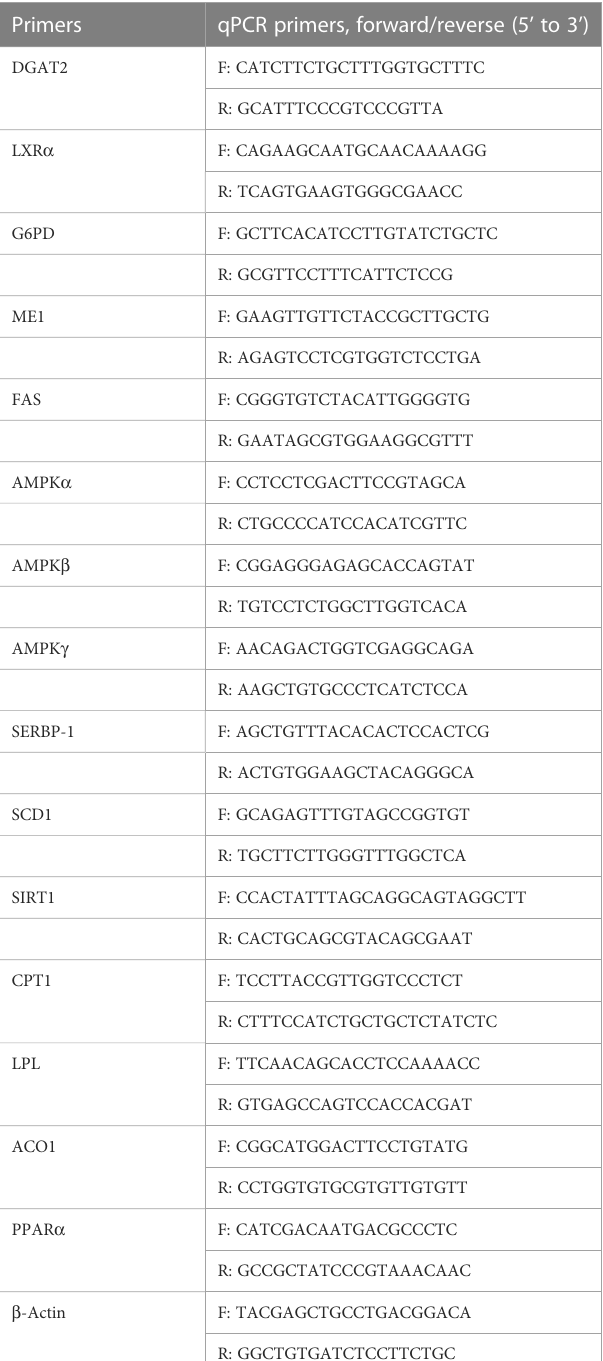
TABLE 2 Primers for qPCR of lipid metabolism related